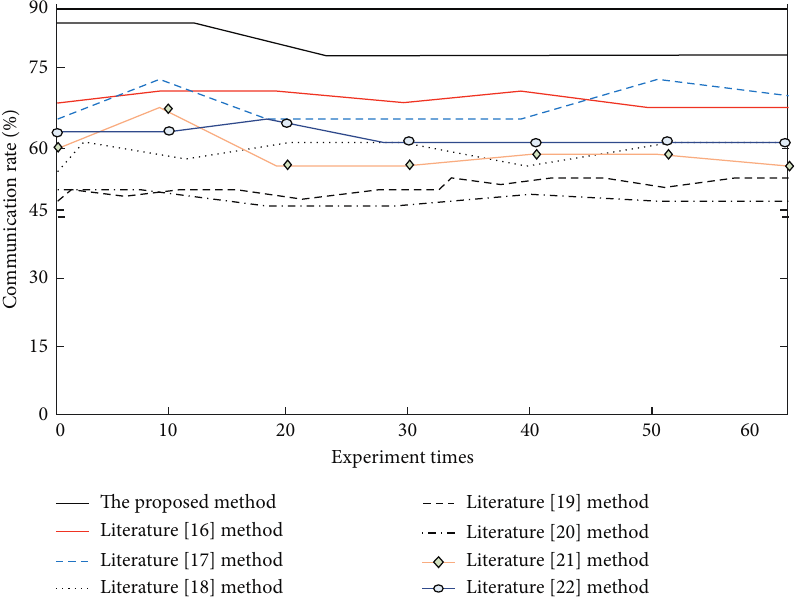
Figure 9: Change of communication rate of different methods.